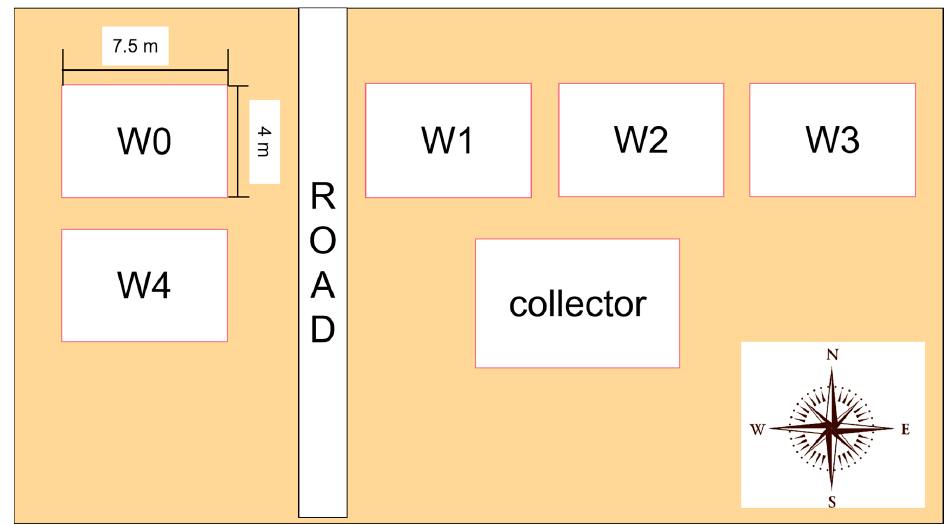
Figure 2. Experimental plot structure diagram. W0, W1, W2, W3 and W4 indicate different water level treatments of 0, 1, 2, 3 and 4. Collector indicates place of the position of the collector. Table 1. Irrigation and precipitation (mm) during the growth period in 2017.